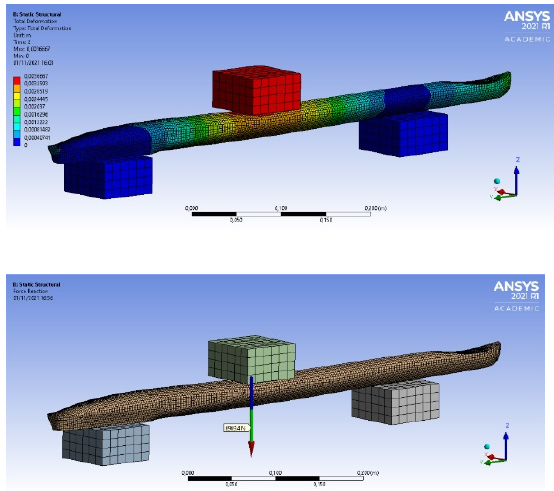
Figure 17. CFRP UD/Twill (displacement 3.61, resulting force 6936 N) .